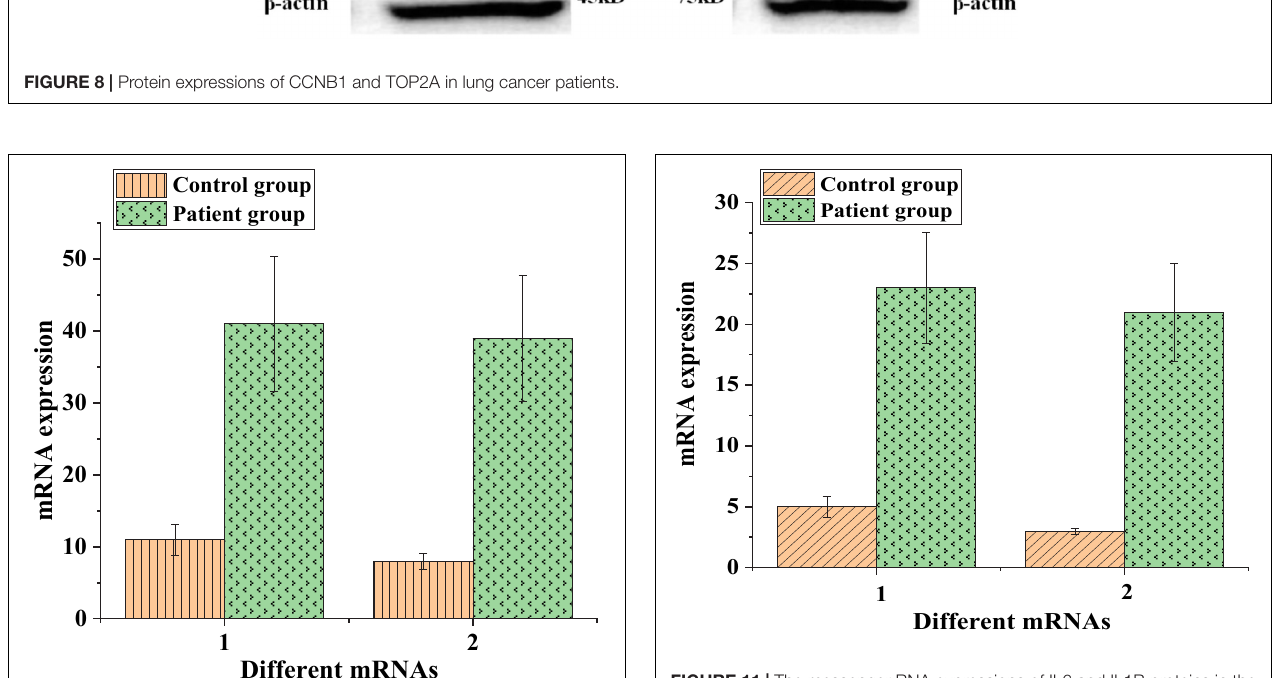
FIGURE 11 | The messenger RNA expressions of IL6 and IL1B proteins in the control and experimental groups (1: IL6; 2: IL1B). protein hydrolysis, mitosis and cell division. TOP2A, CCNB1,